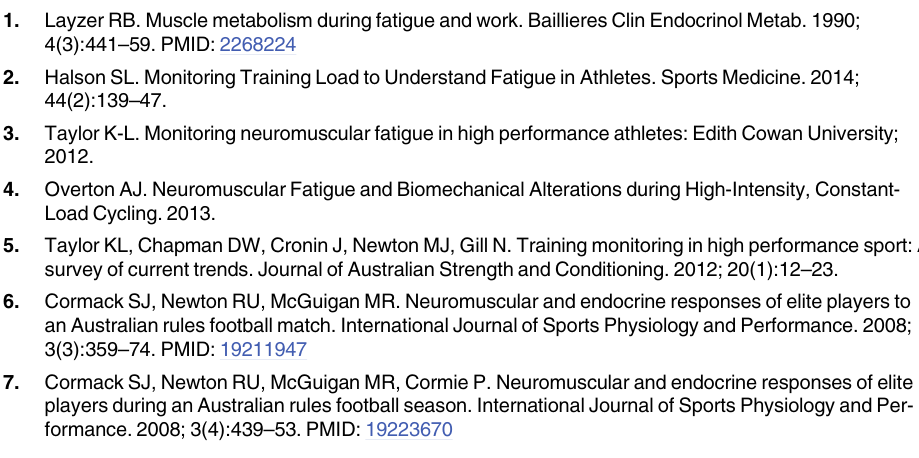
S1 Table. Summary statistics for the standard deviation, proportion of variance and cumu- lative proportion of the principal components (PCs) calculated from the CMJ data. The PCs are a transformation of the data where PC1 describes the most variation in the data, fol- lowed by PC2 and so on. In our study, PC1 corresponds to neuromuscular fatigue effects and PC2 to metabolic fatigue